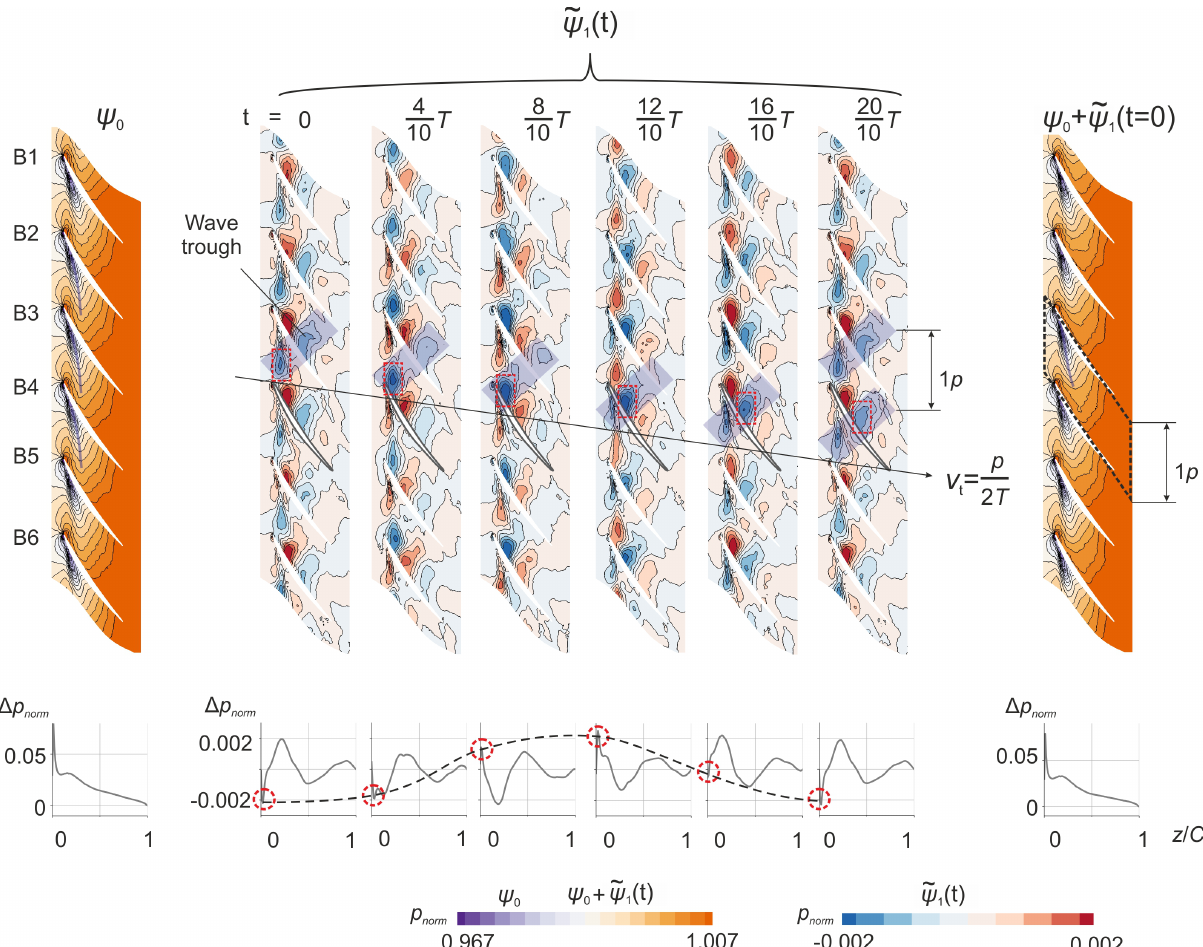
Figure 12. Ensemble-averaged pressure, temporal evolution of dominating mode, example of reconstructed pressure, and profile of blade pressure difference at 95% span for s / C = 2.6% at Φ =